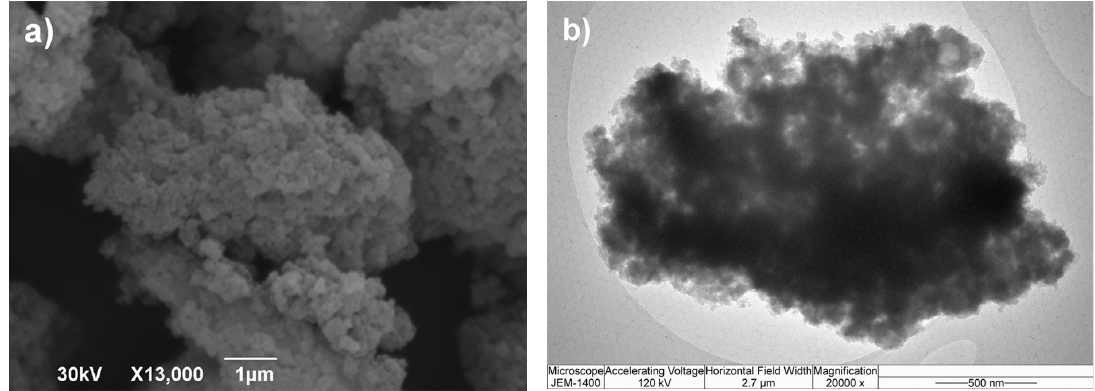
Figure 4. SEM (a) and TEM (b) micrographs of silica core/cobalt ferrite shell particles obtained at pH=15 (sample